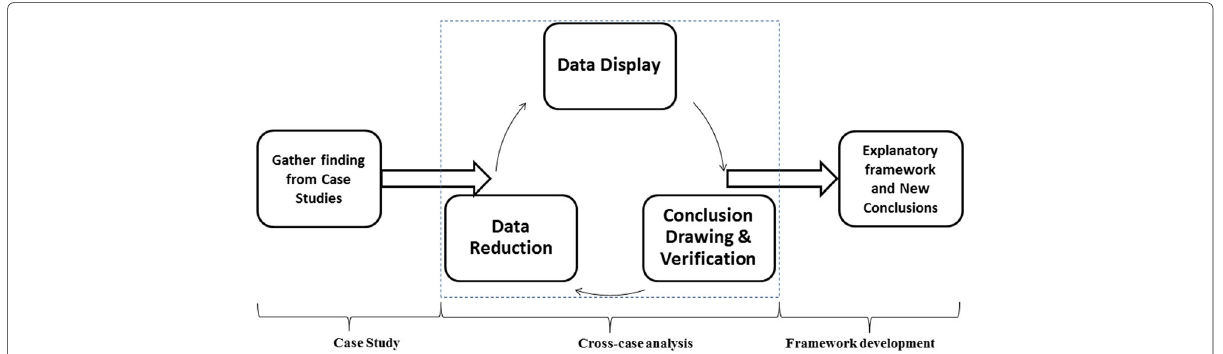
Fig. 1 Cross-analysis technique used for the